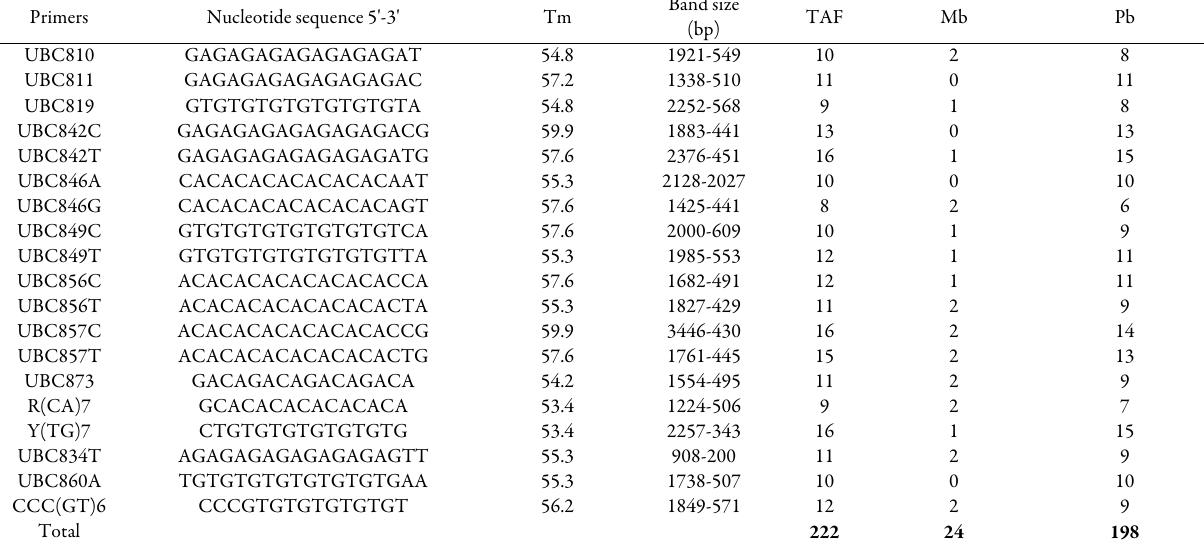
Table 1. Primer score of ISSR analysis for W=wild, SE= Somatic embryogenesis, D= Direct regeneration and ID = Indirect regenerated plants. TAF= Total amplified fragments, Mb= Monomorphic bands, Pb= Polymorphic bands